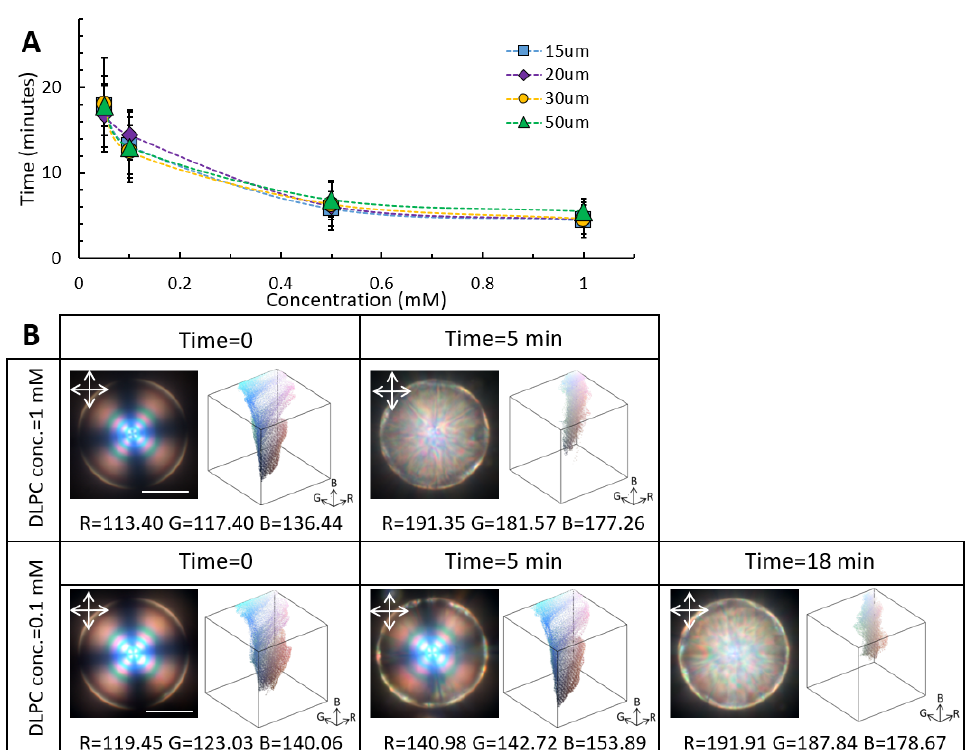
Figure 2. Response time of the high-chirality LC droplet as a function of droplet size and DLPC concentration. ( A ) Response time of the high-chirality droplets as a function of DLPC concentration for various droplet sizes. ( B ) Evolution of the colorimetric channels and color gamut of the 50 µm highly chiral droplets as a function of DLPC concentration (scale bar = 20 µm).